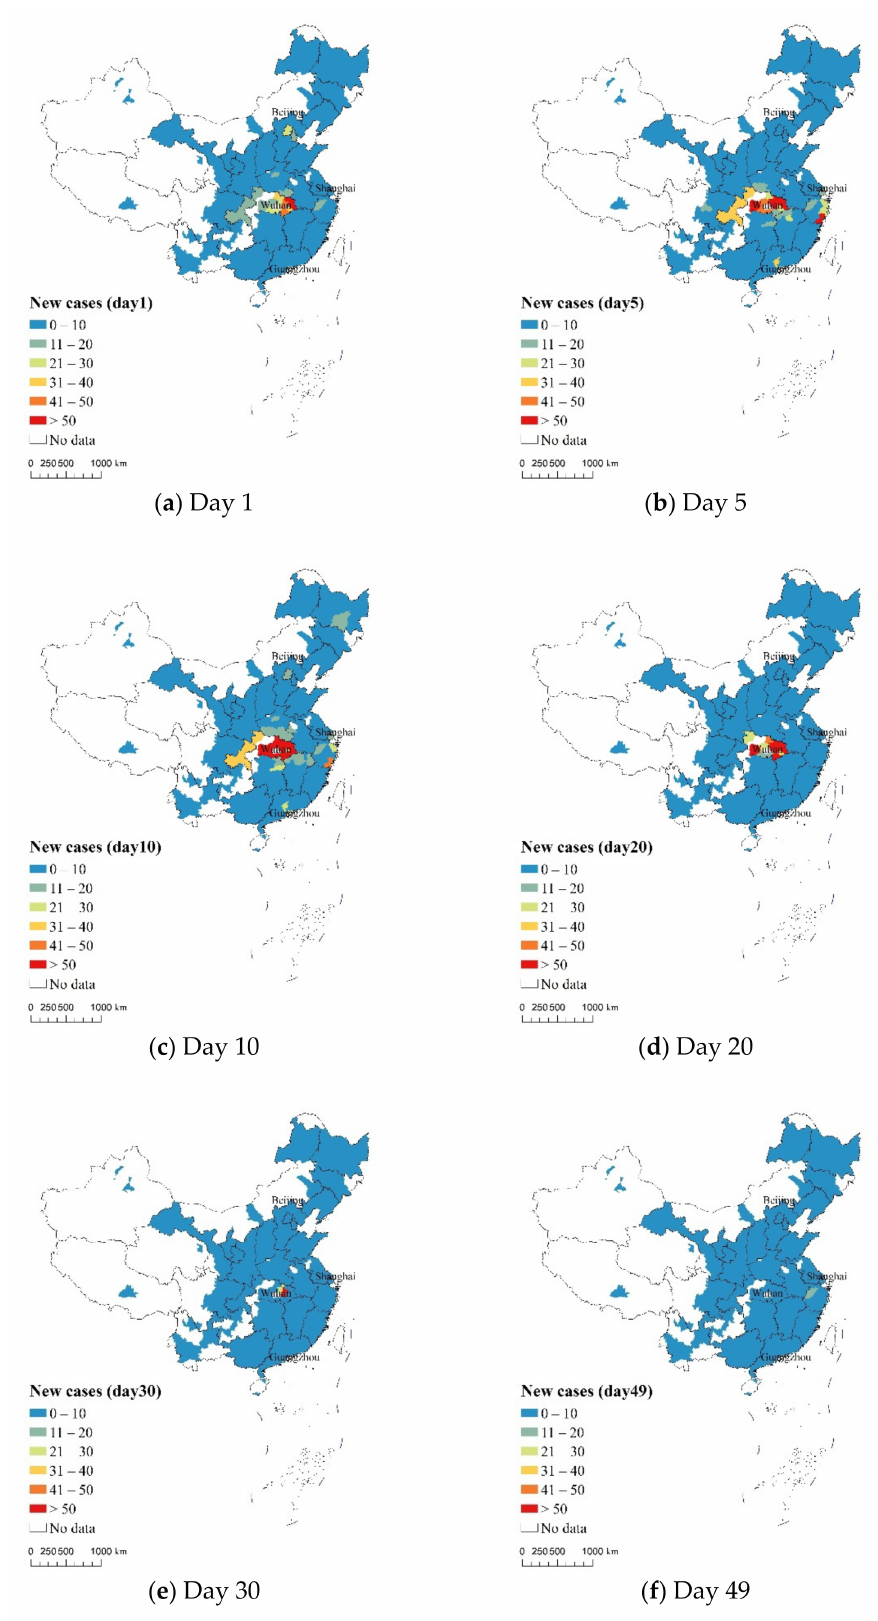
Figure 2. The maps of daily new COVID-19 cases. ( a – f ) are the daily new cases distribution from Day 1 (25 January) to Day 49 (13